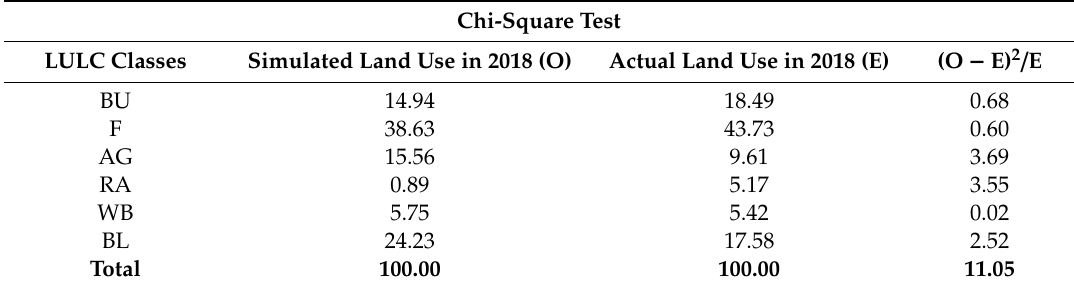
Table 3. Validation of the land use land cover change (LULCC) prediction based on the actual and simulated 2018 LULC image.